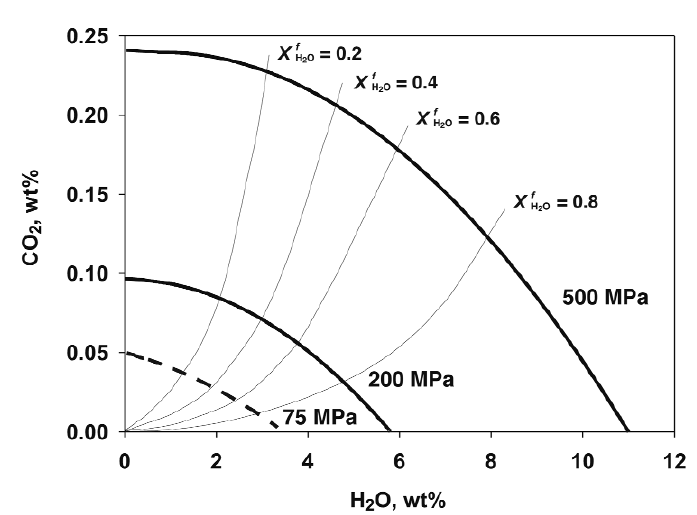
Fig. 1. Typical diagram illustrating solubility of volatiles in aluminosilicate melts in equilibrium with C-O-H fluids. The curves are based on the experimental datasets obtained by Blank et al . (1993) at T = 850°C and P = 75 MPa and Tamic et al . (2001) at T = 1100°C and 200 and 500 MPa for rhyolitic